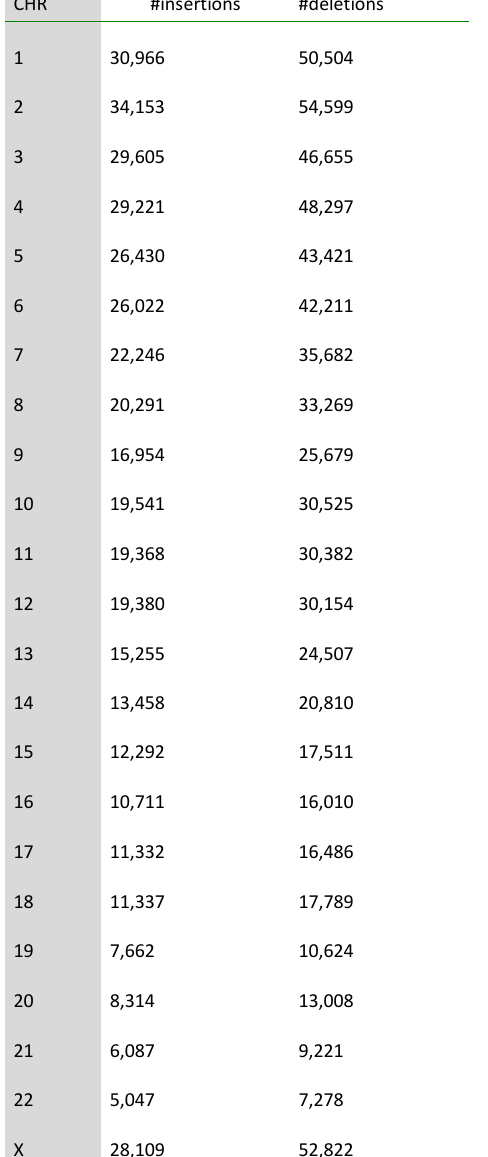
Supplementary Table 2: Annotated Insertions and Deletions for each human chromosome of the 1,000 human genome project phase